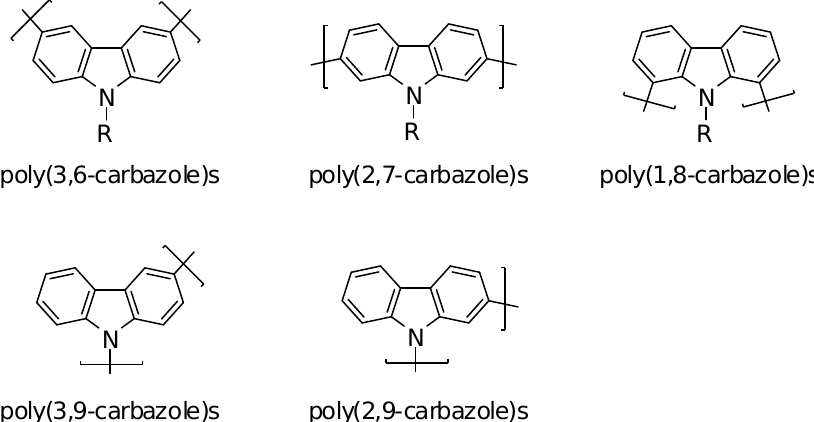
Figure 1. Conjugated carbazole polymers with various